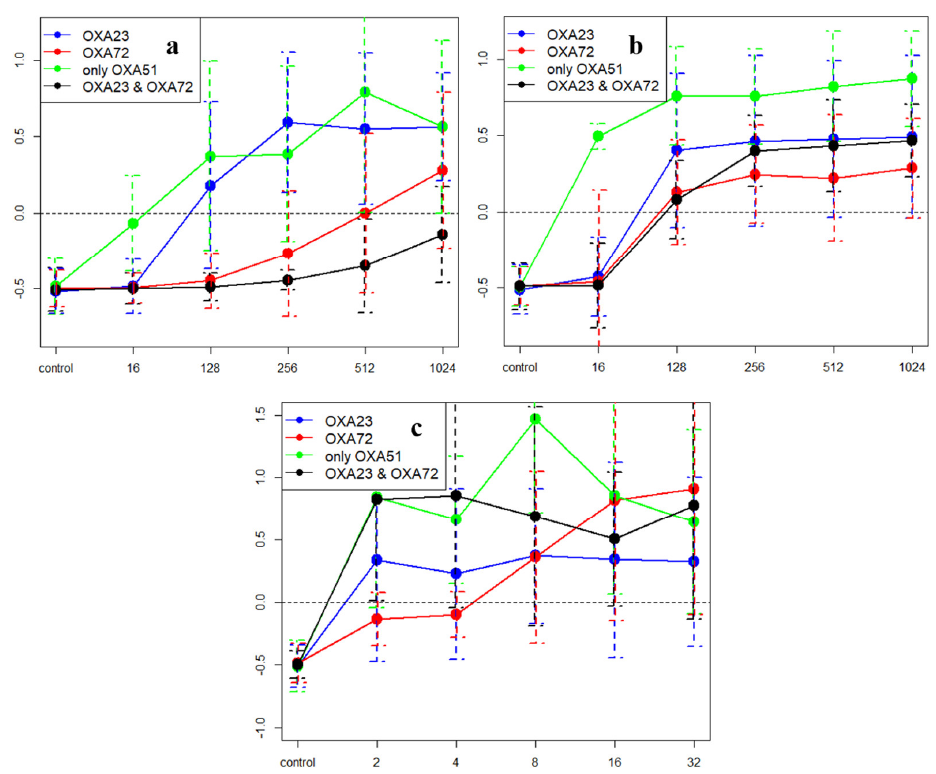
Figure 3. Result of the time-kill assays, X axis shows the drug concentration, Y axis shows the mean k-values. Values above 0 (dashed line) indicate killing effect (see text for details). ( a ) Summary of the results of the time-kill assays against meropenem. ( b ) Summary of the results of the time-kill assay against imipenem. ( c ) Summary of the results of the time-kill assay against colistin.